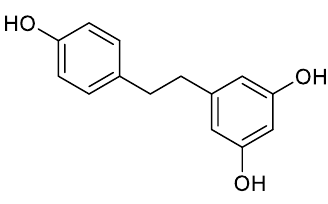
Figure 6. Structure of trans-resveratrol.